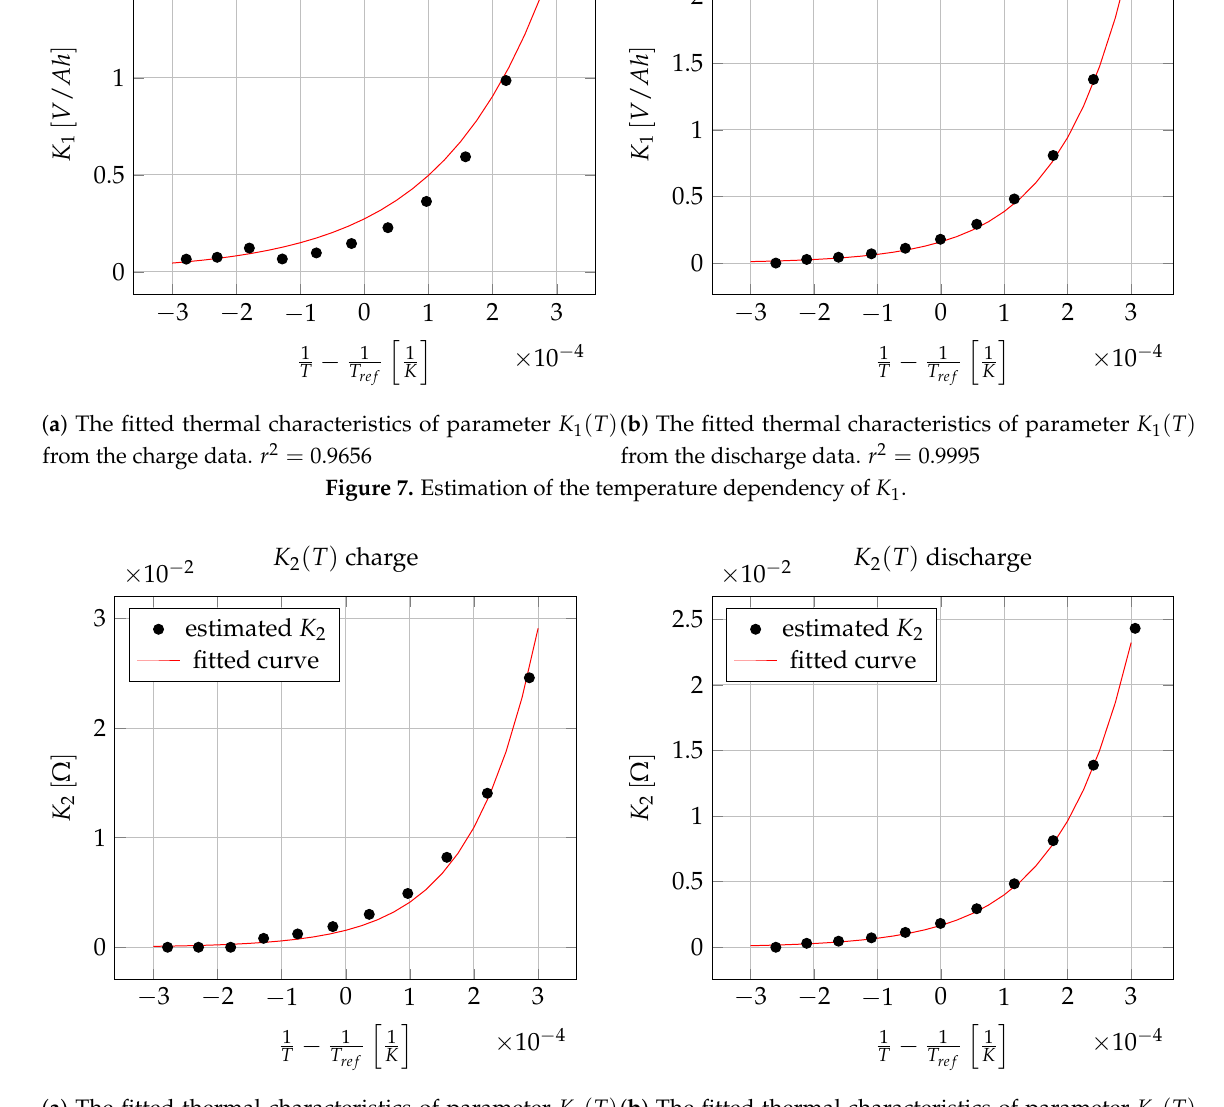
Figure 8. Estimation of the temperature dependency of K 2